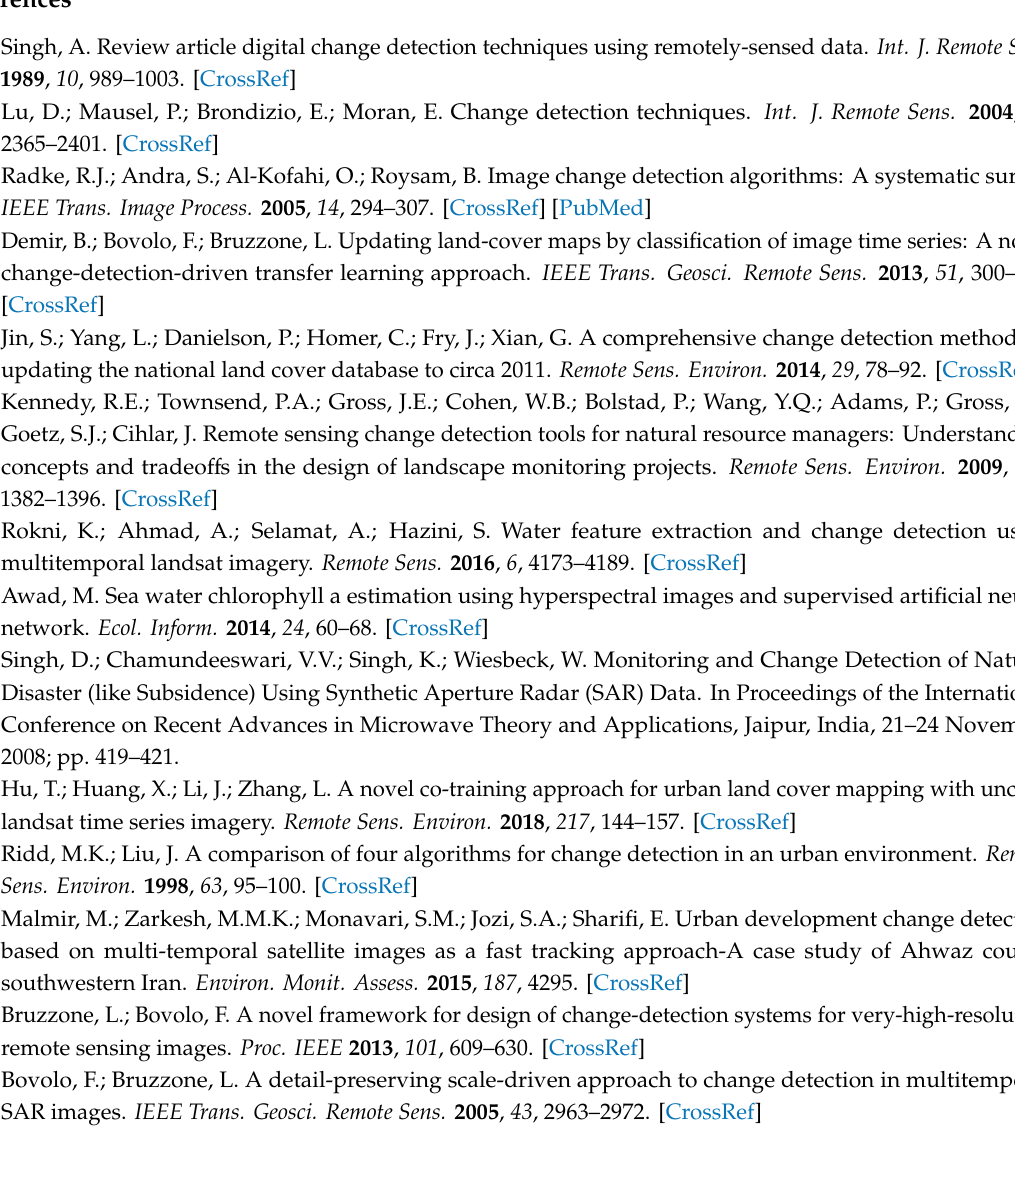
Figure A1. The convergence curves for two datasets: ( a ) SZTAKI benchmark, ( b ) Shenzhen dataset.